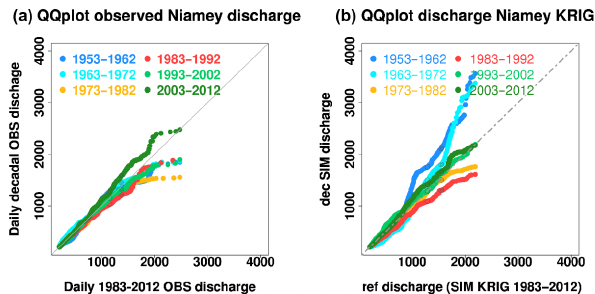
Figure 11. Quantile–quantile plot (Q–Qplot) of the distribution of daily discharge in Niamey (observed in a ; simulated in b ) for each decade since 1953; the reference ( x axis) is the red flood ob- served/simulated daily discharge between 1983 and 2012.